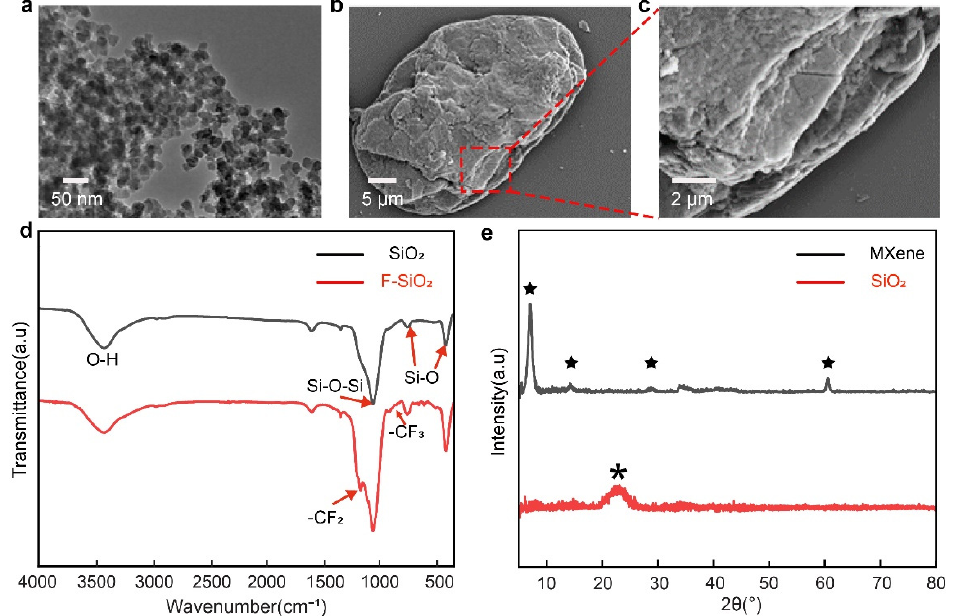
Figure 1. Characterization of the SiO 2 nanoparticles and MXene flakes. ( a ) TEM image of the SiO 2 . ( b – c ) SEM image of the MXene flakes. ( d ) FT-IR spectra of the SiO 2 and F-SiO 2 . ( e ) XRD pattern of the MXene and SiO 2 , the symbols represent different diffraction peaks.